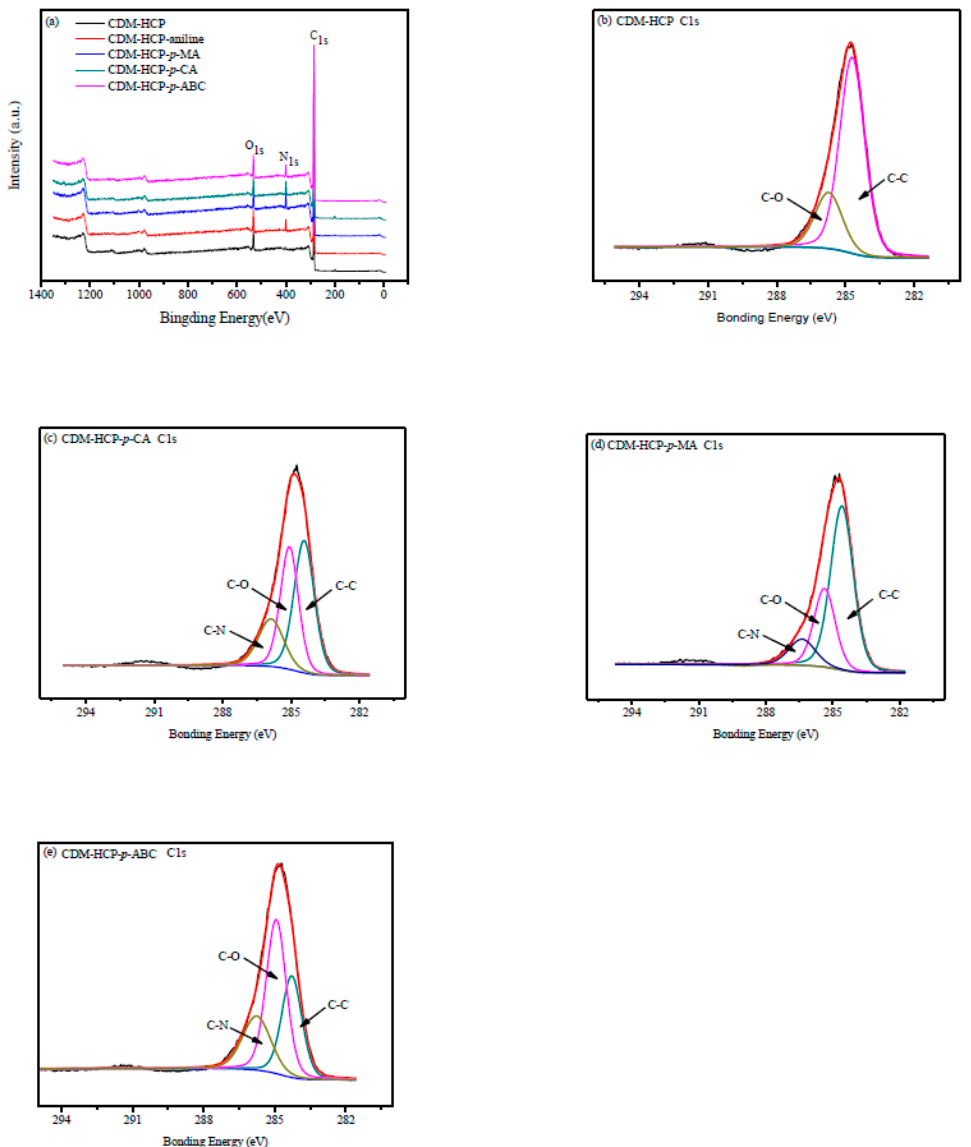
Figure 11. High-resolution XPS spectra of the CDM-HCP ( a ) and C 1s ( b – e ) before and after aniline adsorption.